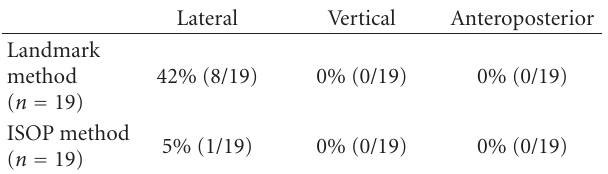
Table 1: Frequency of error of ≥ 5mm from the puncture target. Table 2: Mean ± standard deviation and maximum error from the puncture